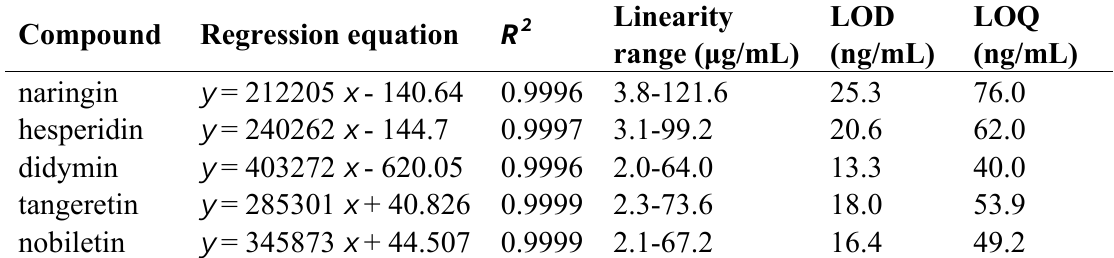
Table 1. Linear regression equation, correlation coefficient and linearity of five flavonoids.